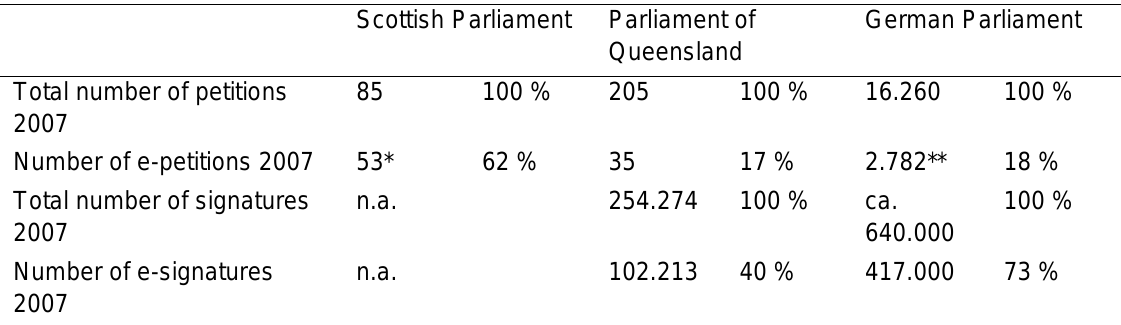
Table 2: Selected (E-)Petition Statistics in Comparison Scottish